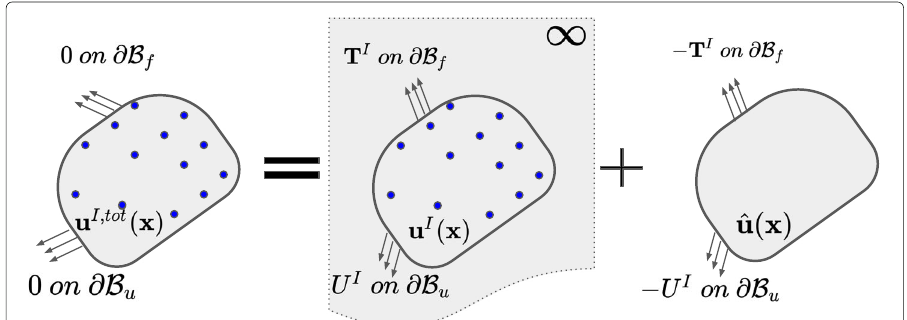
Fig. 2 Decomposition of the problem of a body with solutes (the ( ) I , tot field) into the problem of an infinite volume with the solutes (the ( ) I field) and the complementary problem for the body without the solutes (the ˆ ( ) field)